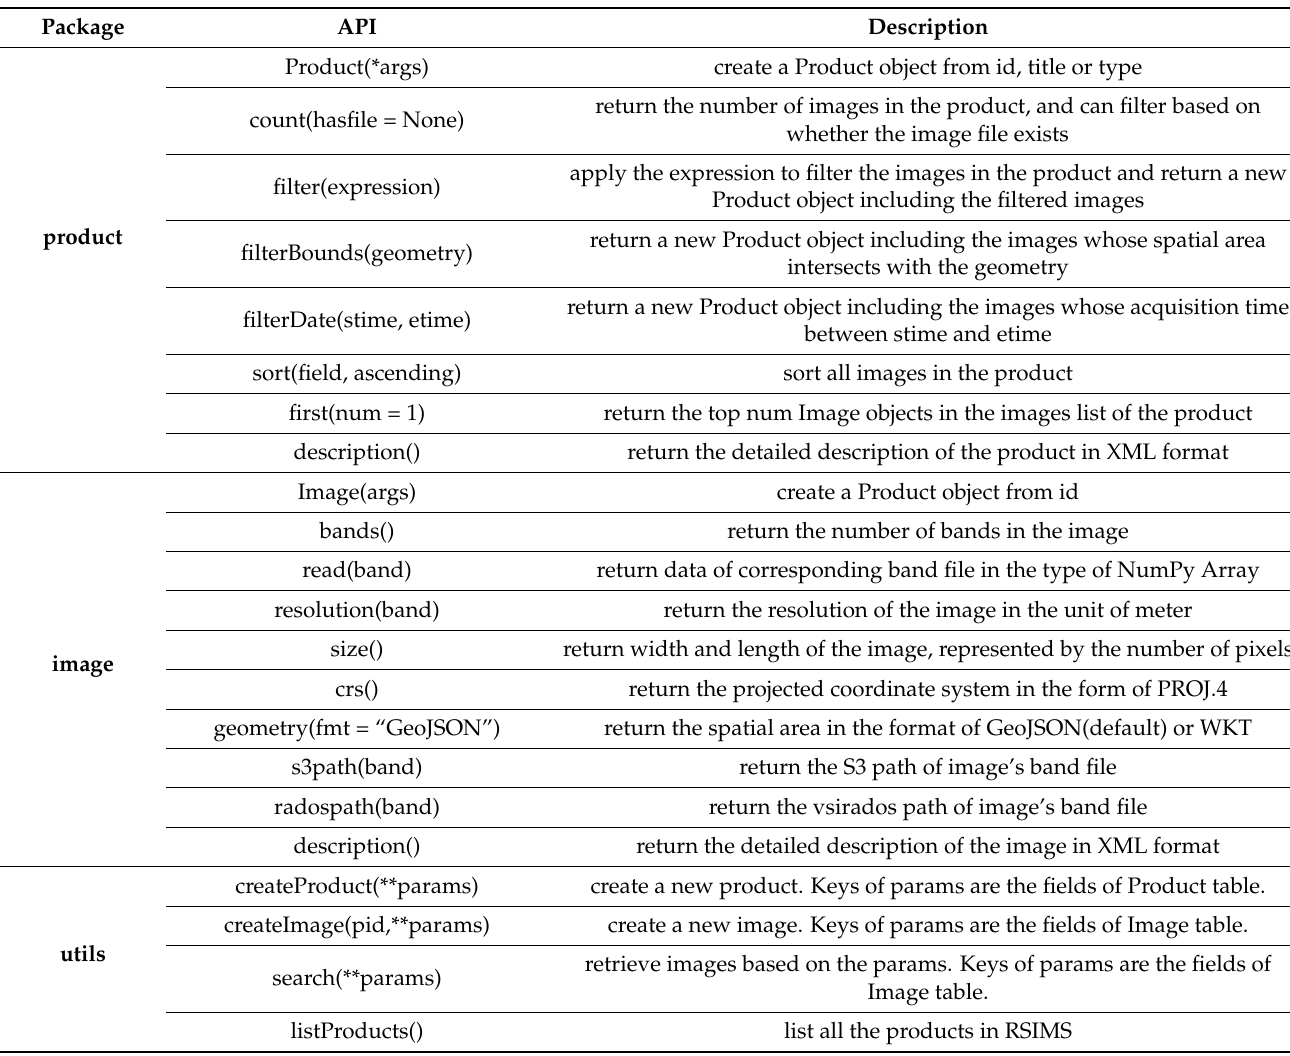
Table 2. Part of frequently-used APIs provided by